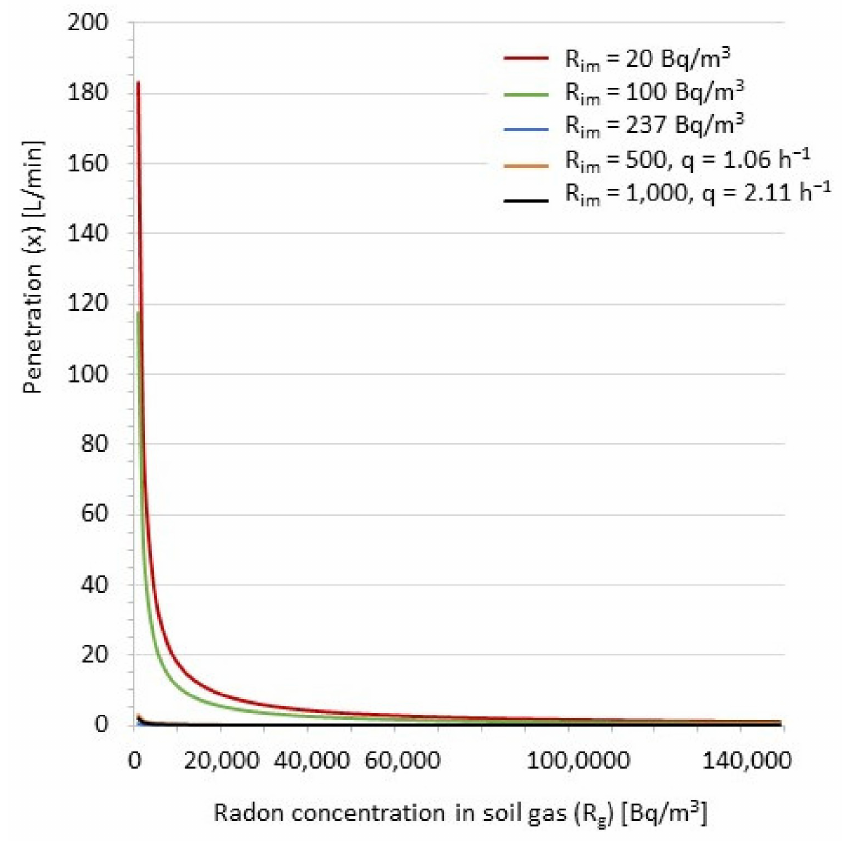
Figure 5. The allowed soil gas penetration with a given radon concentration balancing the radon indoor-air concentration at 100 Bq/m 3 with increased initial radon contributions from indoor materi- als and an air-change rate starting from 20 Bq/m 3 and 0.5 h − 1 ,